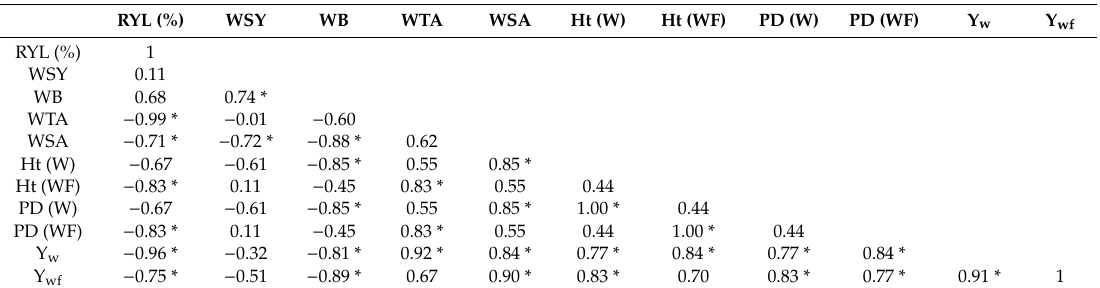
Table 6. Correlation among di ff erent parameters in barley